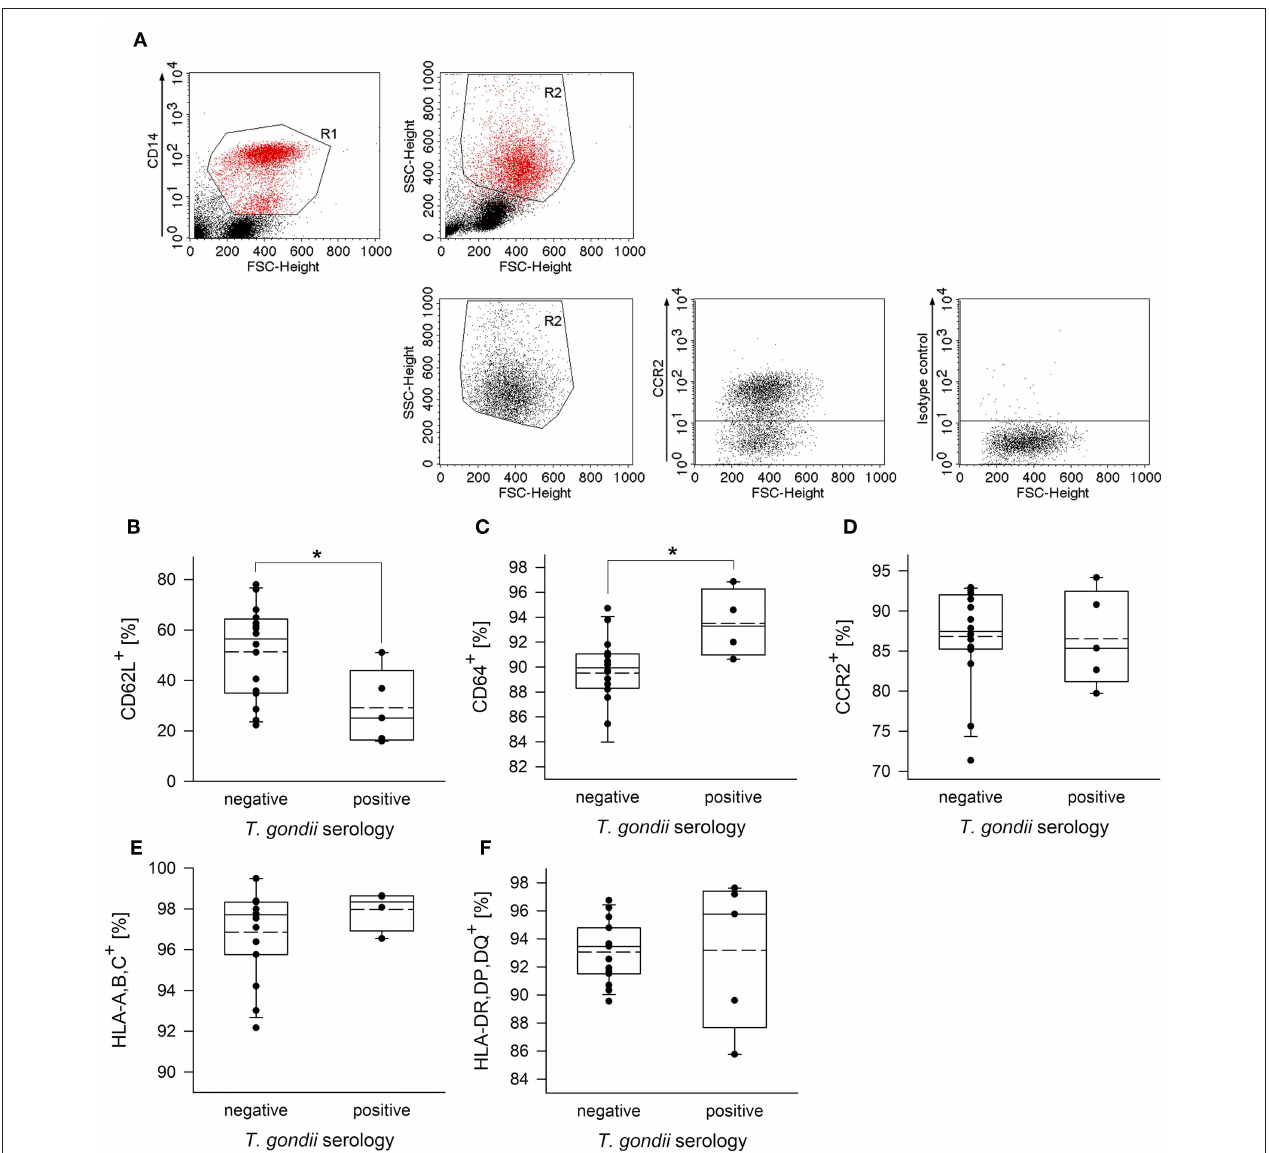
FIGURE 2 | Proportion of CD62L + , CD64 + , CCR2 + , HLA,A,B,C + or HLA,DR,DP,DQ + cells among peripheral blood monocytes from donors with or without chronic toxoplasmosis. Plastic-adherent PBMCs were isolated from blood samples and were fluorescently labeled using FITC-conjugated anti-CD14 or antibodies directed against the indicated surface markers or isotype control antibodies and PE-conjugated secondary antibodies. Blood donors were serologically classified as chronically T. gondii -infected or non-infected using plasma from the blood samples. (A) CD14 + monocytes (R1) were back-gated and identified (R2) among FSC/SSC-analyzed total cells. R2-gated cells were then analyzed for expression of cell surface markers as indicated, and positive cells were identified after specific (anti-CCR2 in (A) ; see Supplementary Figure 2 for the other surface markers) and isotype control labeling. (B–F) Percentages of monocytes from T. gondii seropositive or seronegative individuals positive for cell surface markers as indicated. Solid and dashed lines in the box-whisker plots indicate median and mean values, respectively; circles indicate individual data points. Data are from 5 T. gondii seropositive and 16 seronegative blood donors; outlyers were excluded.* p < 0.05 (Student’s t